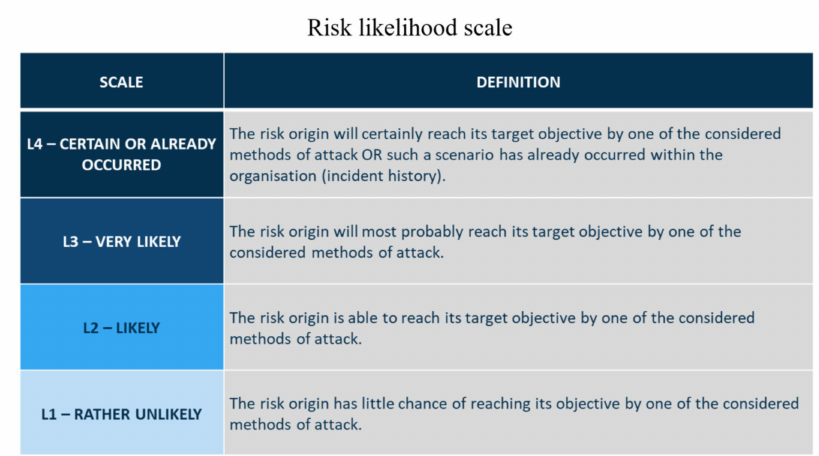
Figure 14. Ob é risk datasheet—workshop n ◦ 4: qualitative risk likelihood